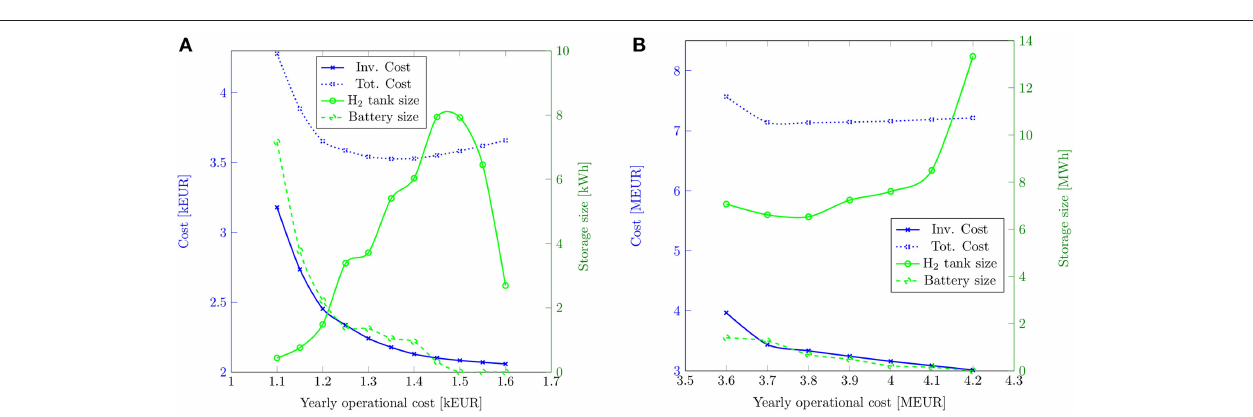
FIGURE 12 | Variation of the annualized investment cost, total yearly cost, and optimal storage sizes for varying yearly operational costs. (A) Off-grid dwelling case and, (B) Cruise ship case.